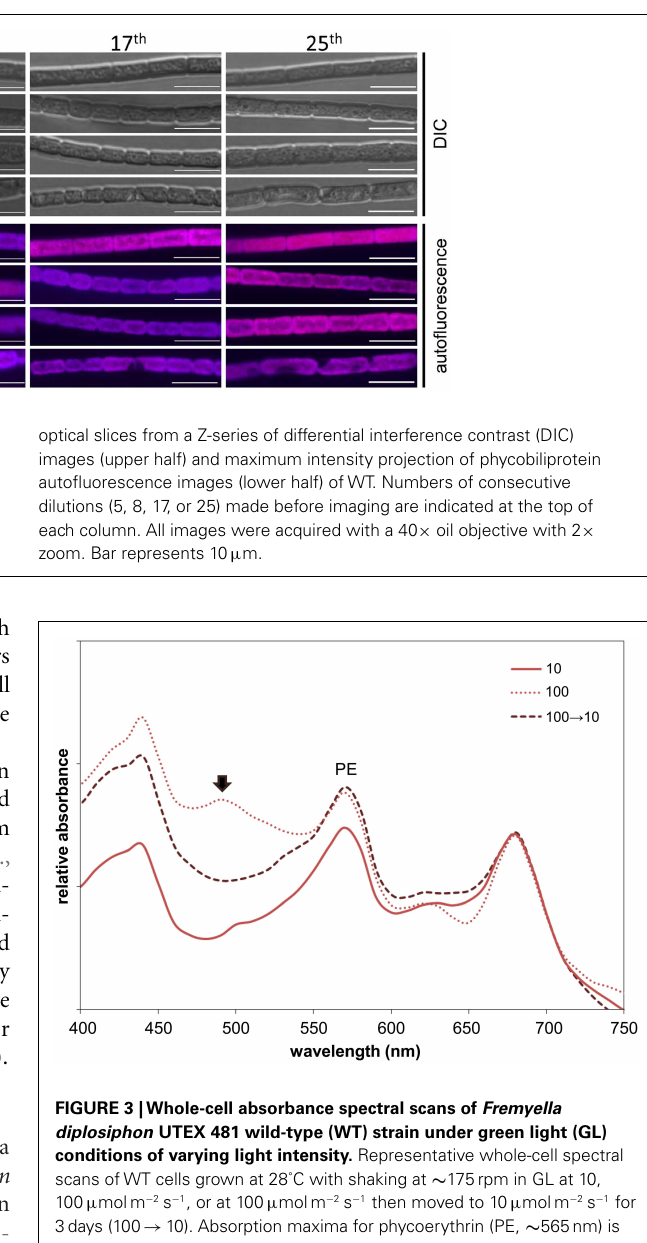
FIGURE 3 |Whole-cell absorbance spectral scans of Fremyella diplosiphon UTEX 481 wild-type (WT) strain under green light (GL) conditions of varying light intensity. Representative whole-cell spectral scans ofWT cells grown at 28˚C with shaking at ∼ 175rpm in GL at 10, 100 μ molm − 2 s − 1 , or at 100 μ molm − 2 s − 1 then moved to 10 μ molm − 2 s − 1 for 3days (100 → 10). Absorption maxima for phycoerythrin (PE, ∼ 565nm) is indicated.The left and right-most peaks ( ∼ 430 and 680nm, respectively) are chlorophyll absorption peaks.The black arrow indicates the peak at ∼ 480–490nm that appears in cells under high GL